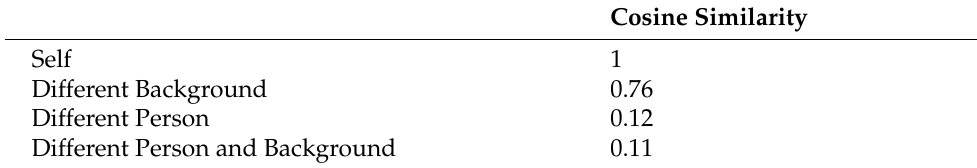
Table 3. Testing robustness to changes in the background. Compares the cosine similarity of embeddings from each image to itself, an image from the same person with different background, an image from a different person with the same background, and an image from a different person and background. Used a selection of 60 images from 20 different actors in 3 background scenes. Each score represents the average of the comparisons taken. Images were taken from the OULU- NPU dataset